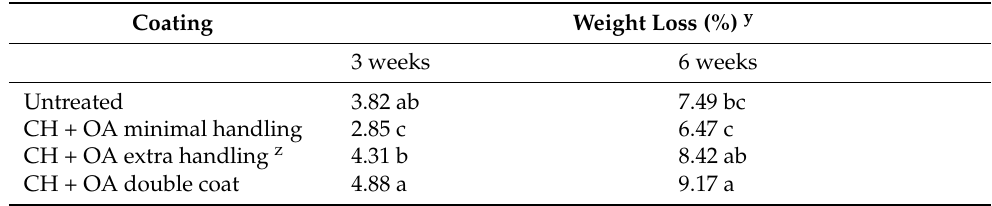
Table 3. Influence of handling and multiple coats on the effectiveness of a chitosan (CH) + oleic acid (OA) dip on the prevention of weight loss following 3 weeks or 6 weeks at 1 ◦ C using purchased blueberries.